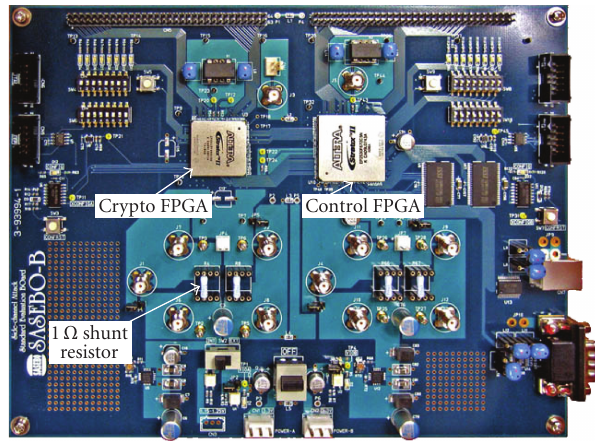
Figure 14: SASEBO-B configuration for the DPA